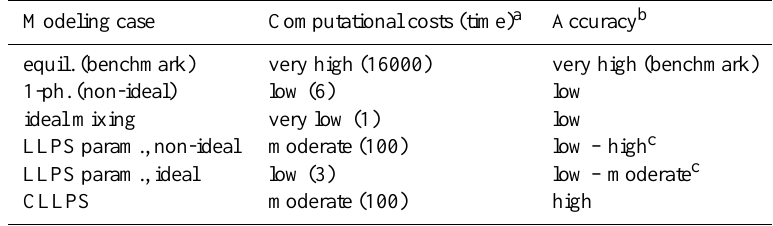
Table 2. Comparison of computational costs and accuracy of the different modeling approaches for organic-inorganic gas-particle partitioning (16-component